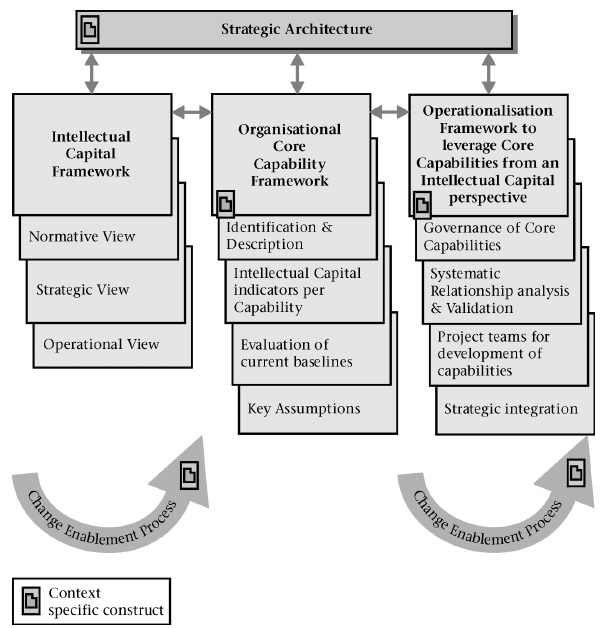
Figure 1: Conceptual Model for the Development of Core Capabilities from an Intellectual Capital